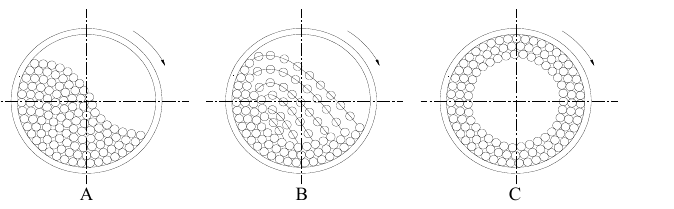
Figure 1. The motion states of grinding medium in the mill ( A ) Cascading state, ( B ) Throwing state, ( C ) Centrifugal state.